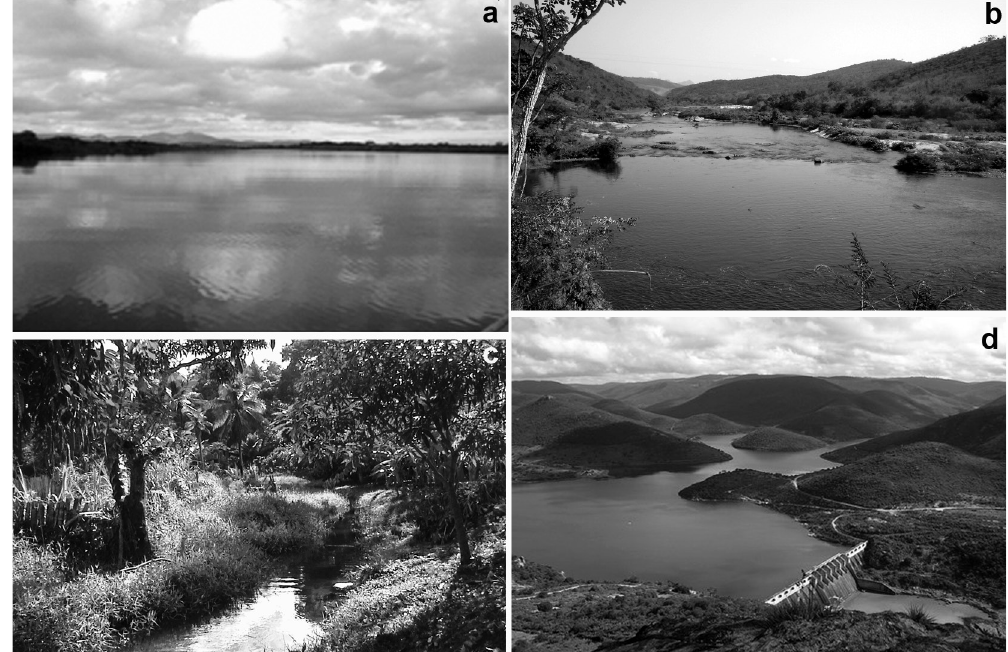
Fig. 2. Partial view of collection sites of Astyanax aff. bimaculatus in the State of Bahia, Brazil: (a) Contas River, upstream Pedra Dam, Porto Alegre County – site A, (b) Contas River, downstream Pedra Dam, city of Jequié – site B, and (c) Mineiro stream, Recôncavo Sul Basin, city of Itamari – site C. In (d), view of Pedra Dam reservoir in Middle Contas River, city of